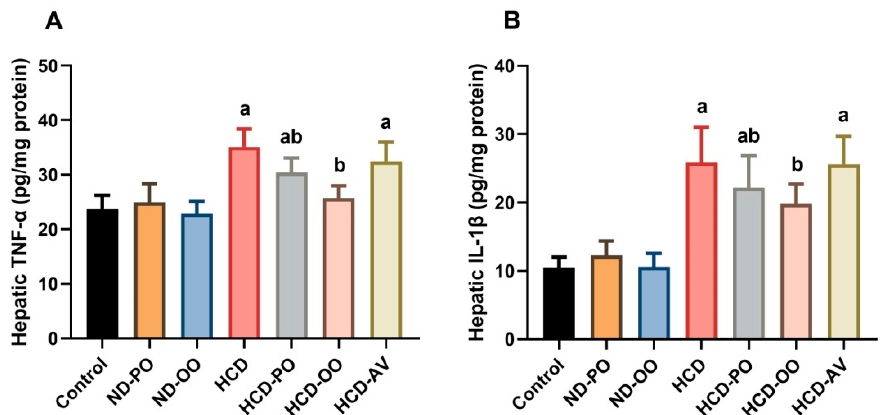
Figure 7. Hepatic levels of pro-inflammatory cytokines (( A ) IL-1 β and ( B ) TNF- α ) following treatment with palm oil (PO), olive oil (OO), or atorvastatin (AV) in high-cholesterol diet-induced hypercholesterolemia in rats. Data are expressed as the mean ± SD ( n = 7). Letters a and b indicate statistically significant differences between control rats and hypercholesterolemia rats, respectively, at p <0.05.